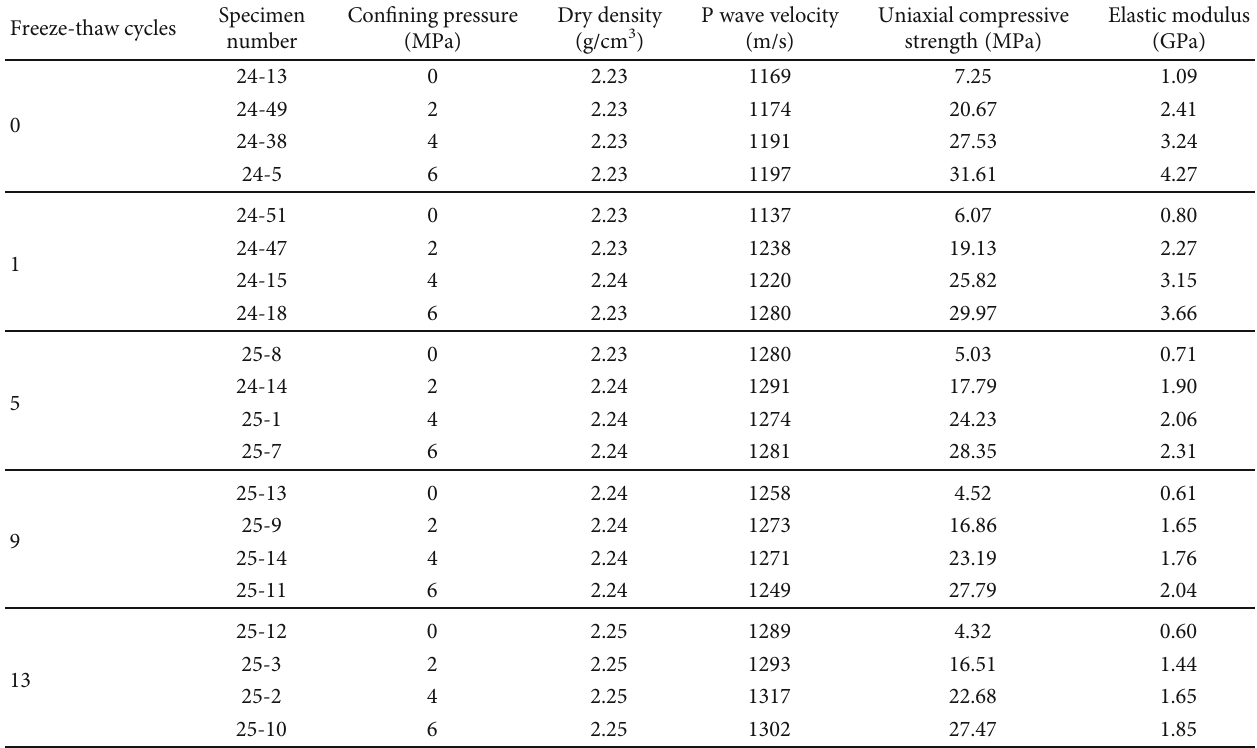
Table 2: Results of the conventional triaxial compression tests of red sandstone after freezing-thawing. Freeze-thaw